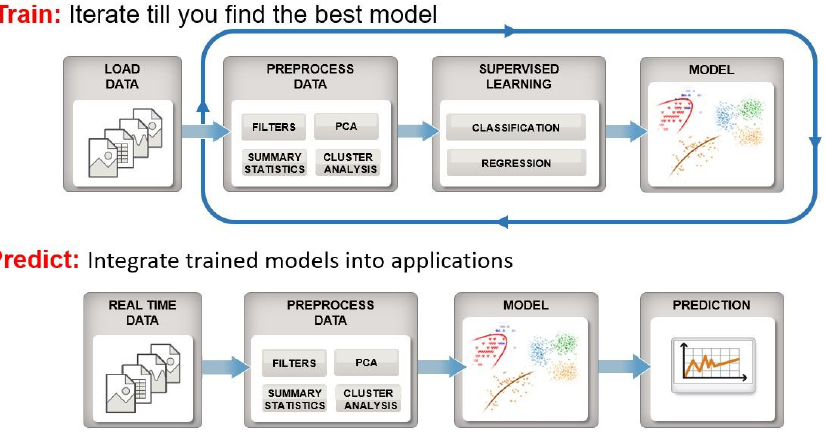
Fig. 4. Machine learning